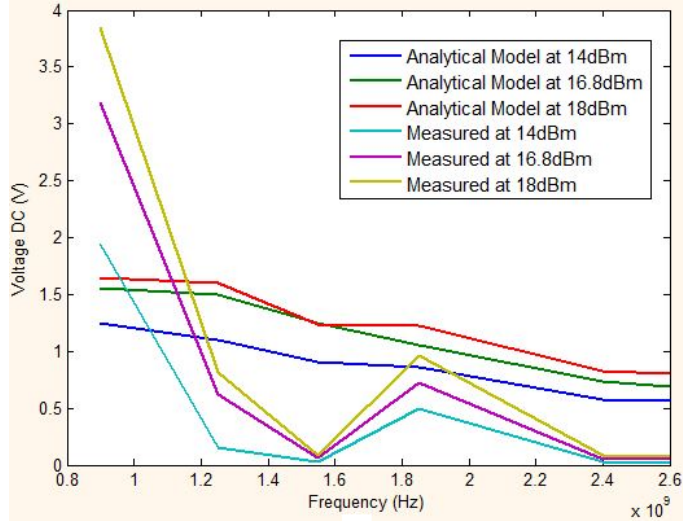
Figure 7. Analytical model and measured output voltages for the RF ‐ EH (five ‐ stage voltage multiplier) at 5 cm, without a load.